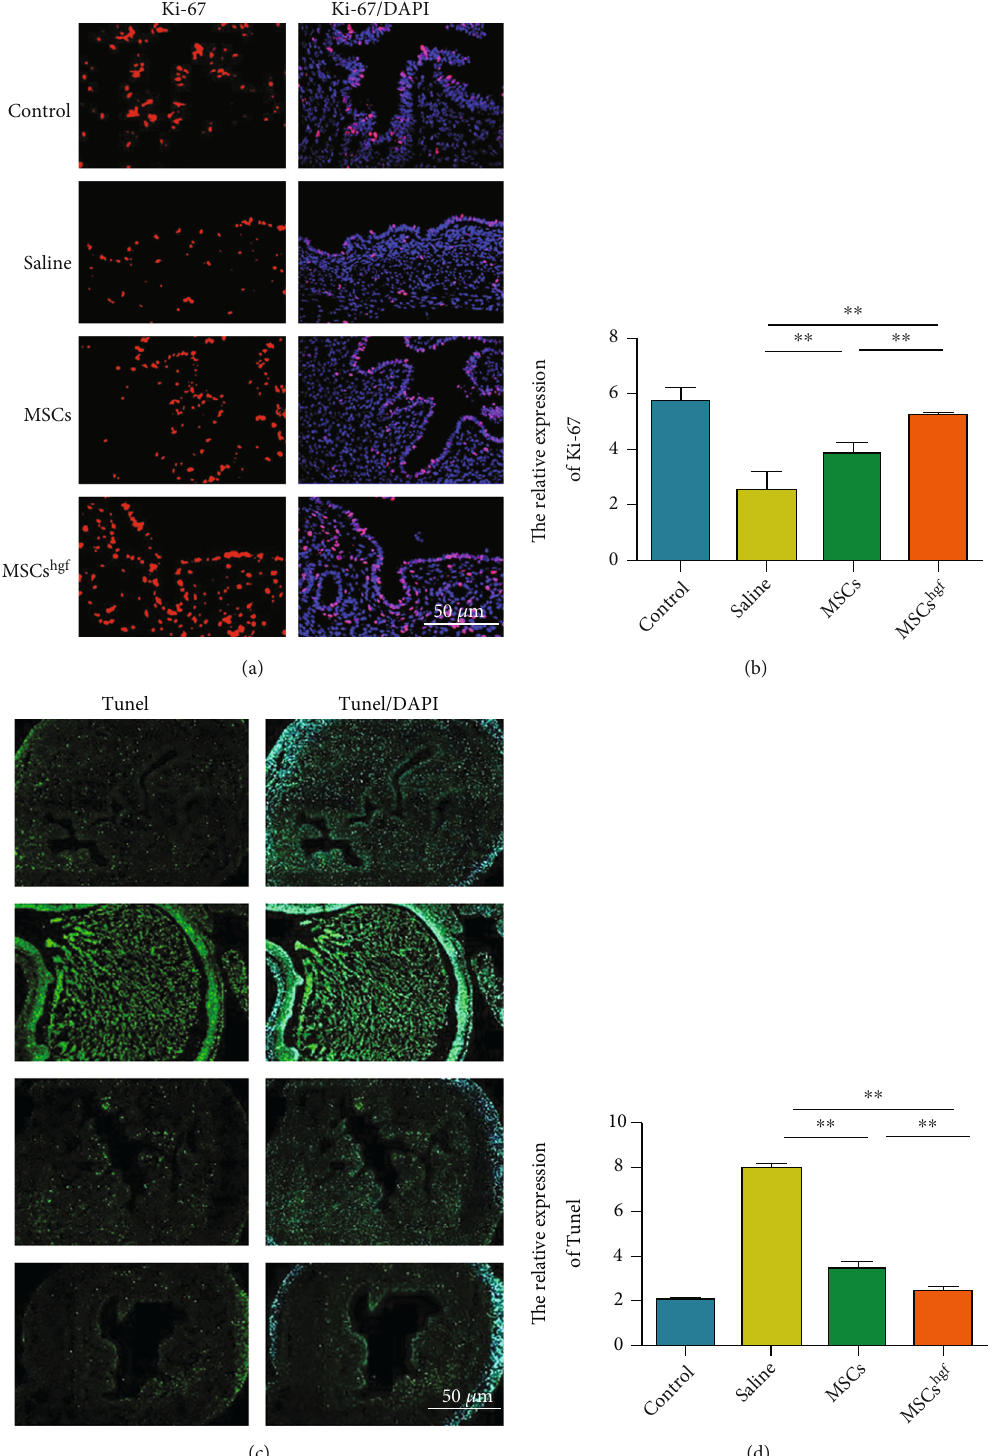
Figure 3: HGF gene-transfected MSCs increase proliferation and decrease apoptosis of endometrial cells in the uterus. (a) Representative images of Ki-67 immuno fl uorescence in each treatment group. (b) Statistical analysis of Ki-67 immuno fl uorescence intensity in each treatment group ( ∗∗ P < 0 : 01 , n = 3 ). (c) Representative images of TUNEL immuno fl uorescence in each treatment group. (d) Statistical analysis of TUNEL immuno fl uorescence intensity in each treatment group ( ∗∗ P < 0 : 01 , n = 3